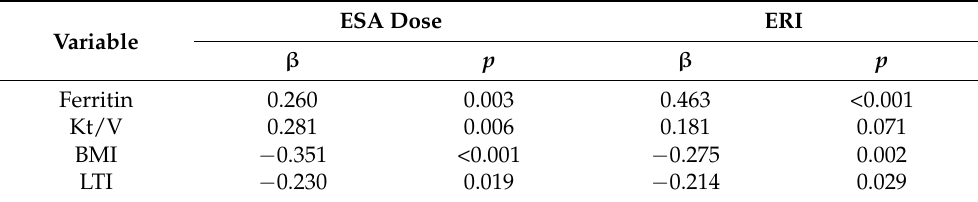
Table 5. Multivariate linear regression analysis predicting determinants of ESA